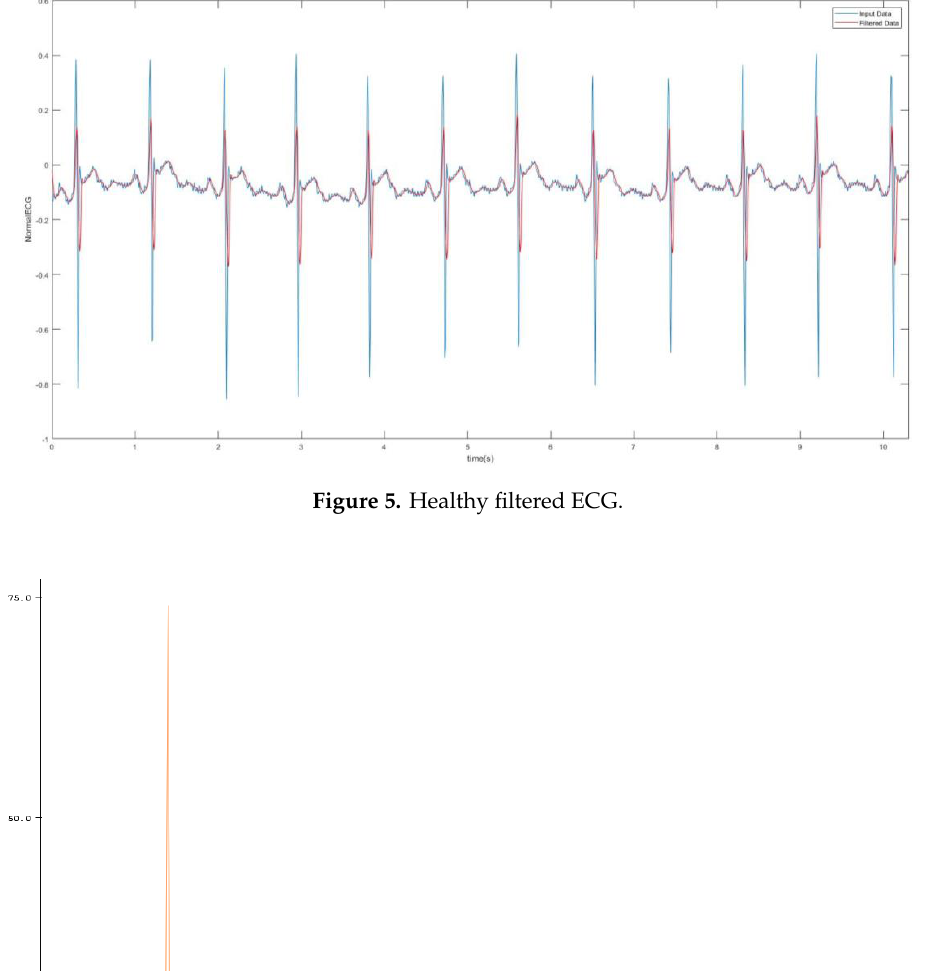
Figure 5. Healthy filtered ECG.